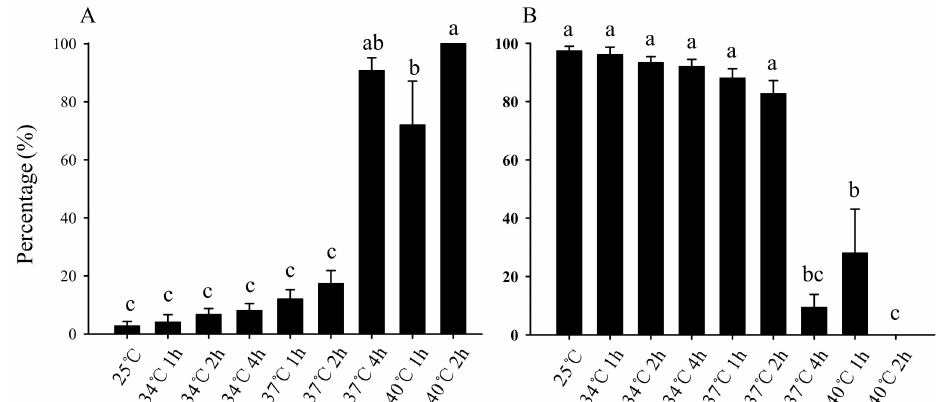
Figure 1. E ff ect of short-term high-temperature stress on Bradysia odoriphaga third-instar larvae first 5 day mortality ( A ) and pupation rate ( B ). The larvae were considered to be dead if they did not move when gently touched with a brush. Just after the transformation from larvae into pupae, pupae were counted daily. Values are means ± SD of five replicates (each of replicate n = 60, total number of each treatment N = 300). Within each panel, bars with di ff erent letters are significantly di ff erent according to Tukey’s test ( p < 0.05